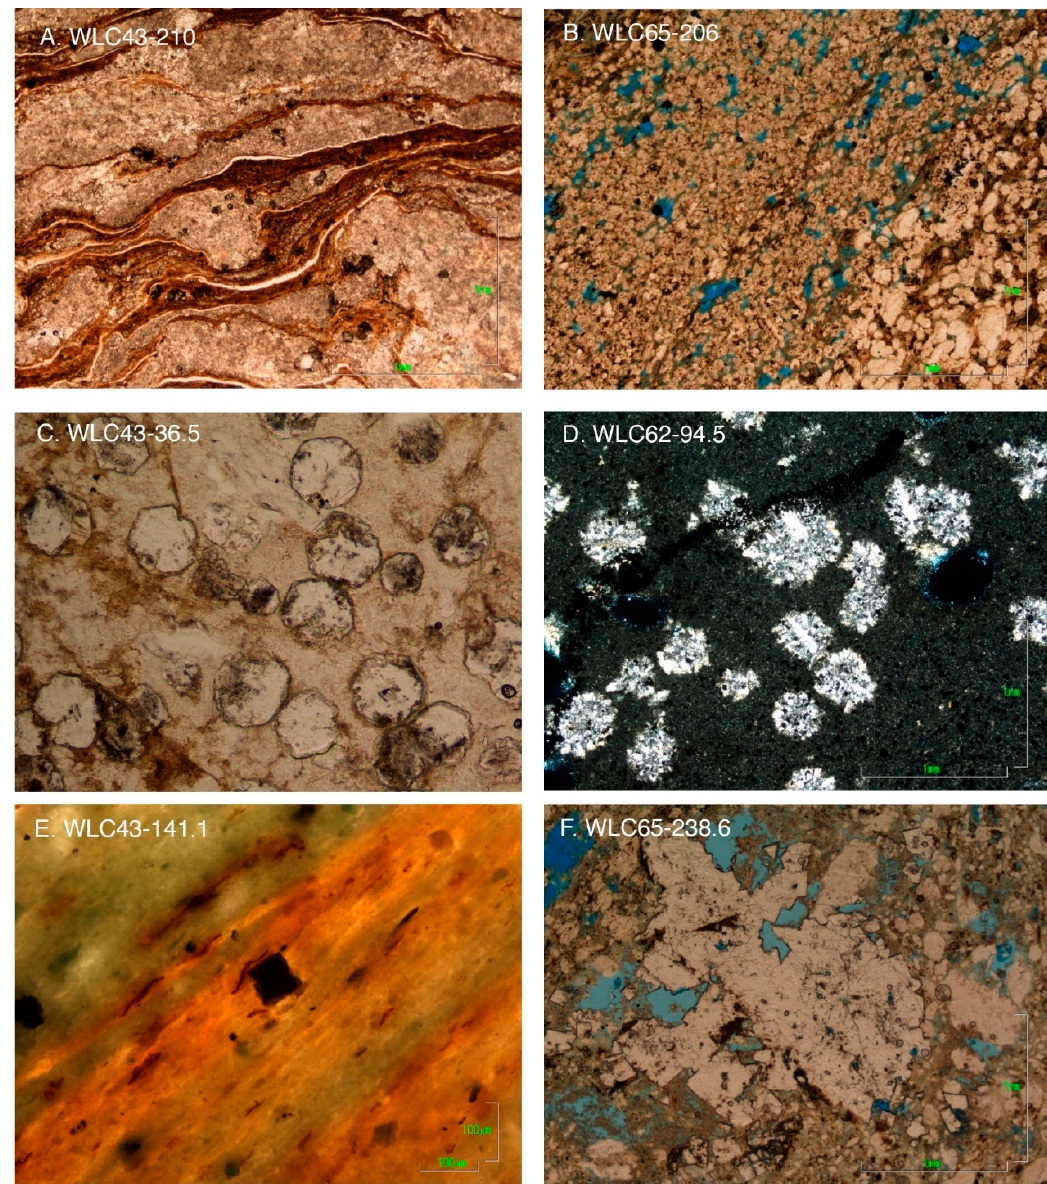
Figure 11. Thin sections. ( A ) Irregularly interlayered brown clay and calcite in core sample WLC43-210 feet (64 m), plane polarized light, horizontal field = 3.2 mm. From interval with 1720 ppm Li. ( B ) Clayey sandstone, sample WLC65-206.7 feet (63 m), plane polarized light, horizontal field of view = 3.2 mm. Light-colored grains are quartz; interstices mostly filled with brown clay and black pyrite. Blue is epoxy-filled pore space. ( C ) Analcime crystals in tuff layer, smectite zone, sample WLC43-36.5 feet (11 m), plane polarized light, horizontal field = 0.8 mm. Mostly granular secondary quartz, brown mineral is smectite. From interval with 142 ppm Li. ( D ) Albite (bright) pseudomorphs probably after analcime in fine-grained tuff (gray), and pyrite (dark grains in vein), sample WLC62-94.5 feet (29 m), cross polarized light, horizontal field of view = 3.2 mm. From interval with 4070 ppm Li. ( E ). Laminated claystone with pyrite cubes and bitumen shards, illite zone, sample WLC43-141.1 feet (43 m), plane polarized light, horizontal field = 0.8 mm. From interval with 6920 ppm Li. ( F ) Fluorite (bright mass of cubic crystals) in sandy mudstone, base of illite zone, sample WLC65-238.6 feet (73 m), plane polarized light, horizontal field of view = 3.2 mm. Blue is epoxy. From interval with 5670 ppm Li.